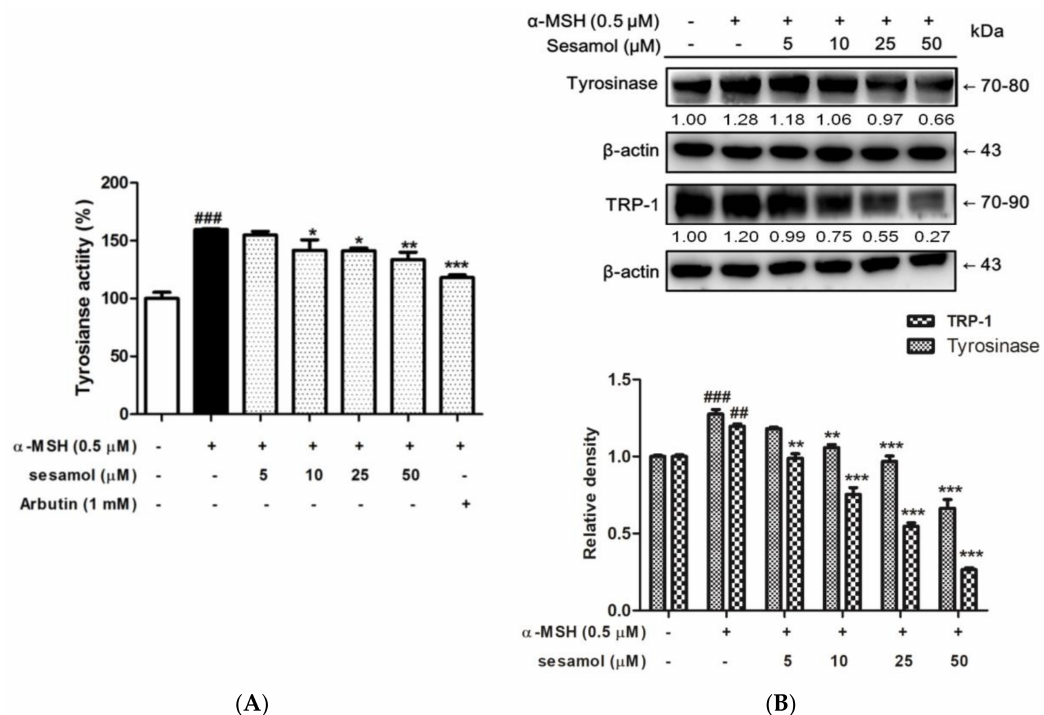
Figure 3. ( A ) Tyrosinase activity (%) of B16F10 cells after 48 h of treatment with sesamol. Sesamol inhibited tyrosinase activity in B16F10 cells. Each value is presented as the mean ± SD. Significant difference versus control: ### p < 0.001. Significant difference versus α -MSH-treated group: * p < 0.05, ** p < 0.01, *** p < 0.001. Positive control: 1 mM arbutin. ( B ) Effect of sesamol on α -MSH-induced protein expression of tyrosinase and TRP-1 in B16F10 cells. Sesamol suppressed tyrosinase and TRP-1 protein levels. Each value is presented as the mean ± SD. Significant difference versus control: ### p < 0.001, ## p < 0.01. Significant difference versus α -MSH-treated group:** p < 0.01, *** p <